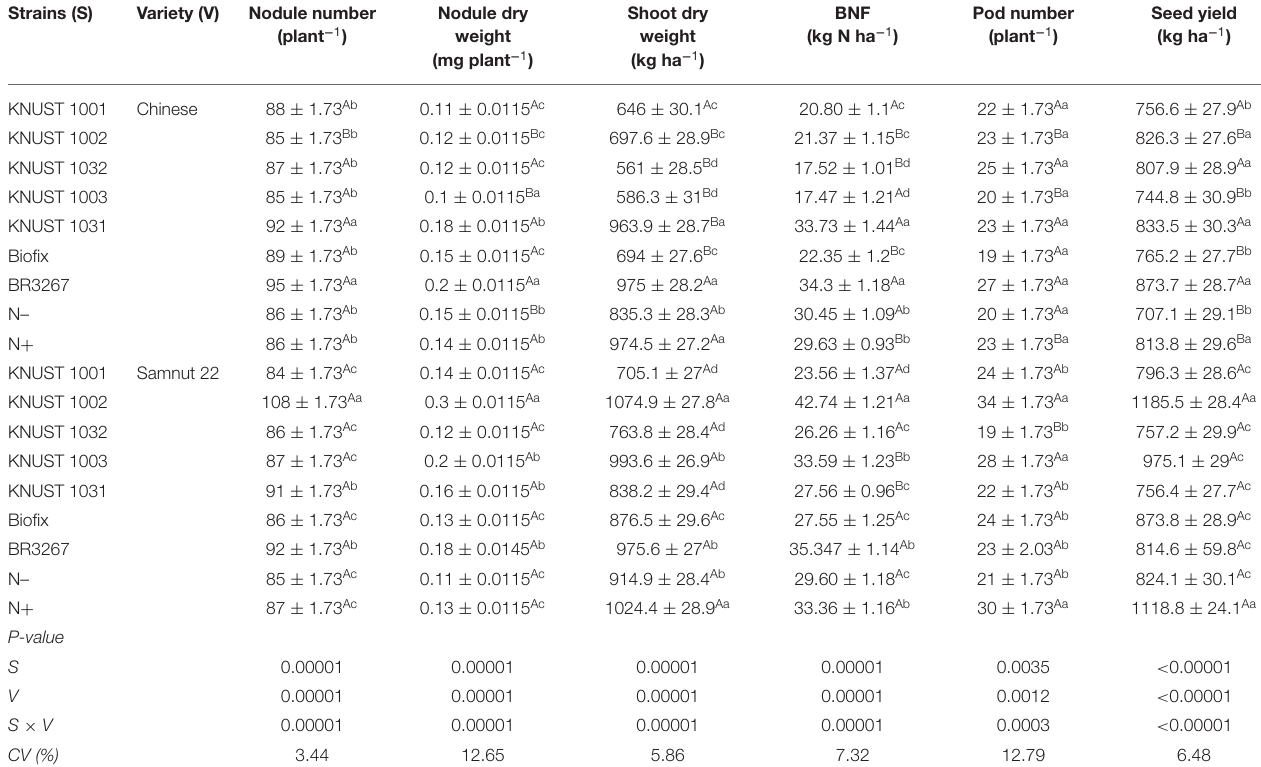
TABLE 4 | The response of groundnut to rhizobia inoculation and mineral N application at Tanina. Strains (S) Variety